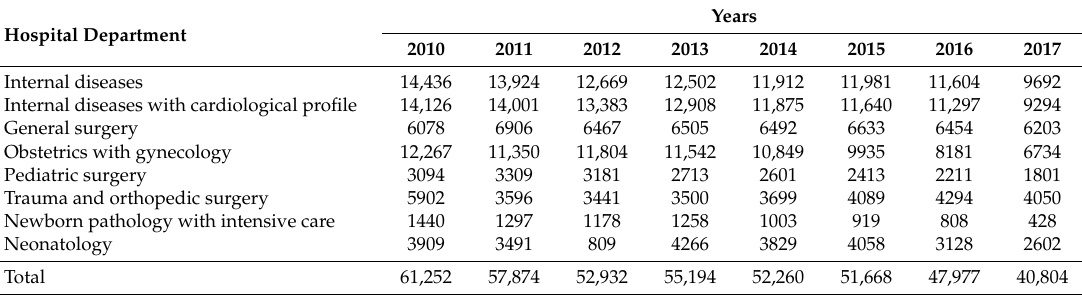
Table 1. Number of inpatients-days in selected departments by